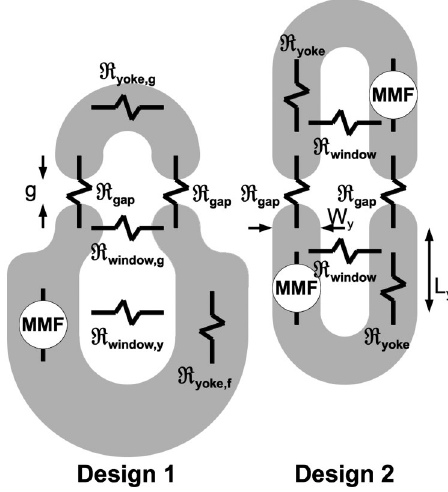
FIG. 4. Illustration of a simple reluctance model of the two undulator designs illustrated in Fig.